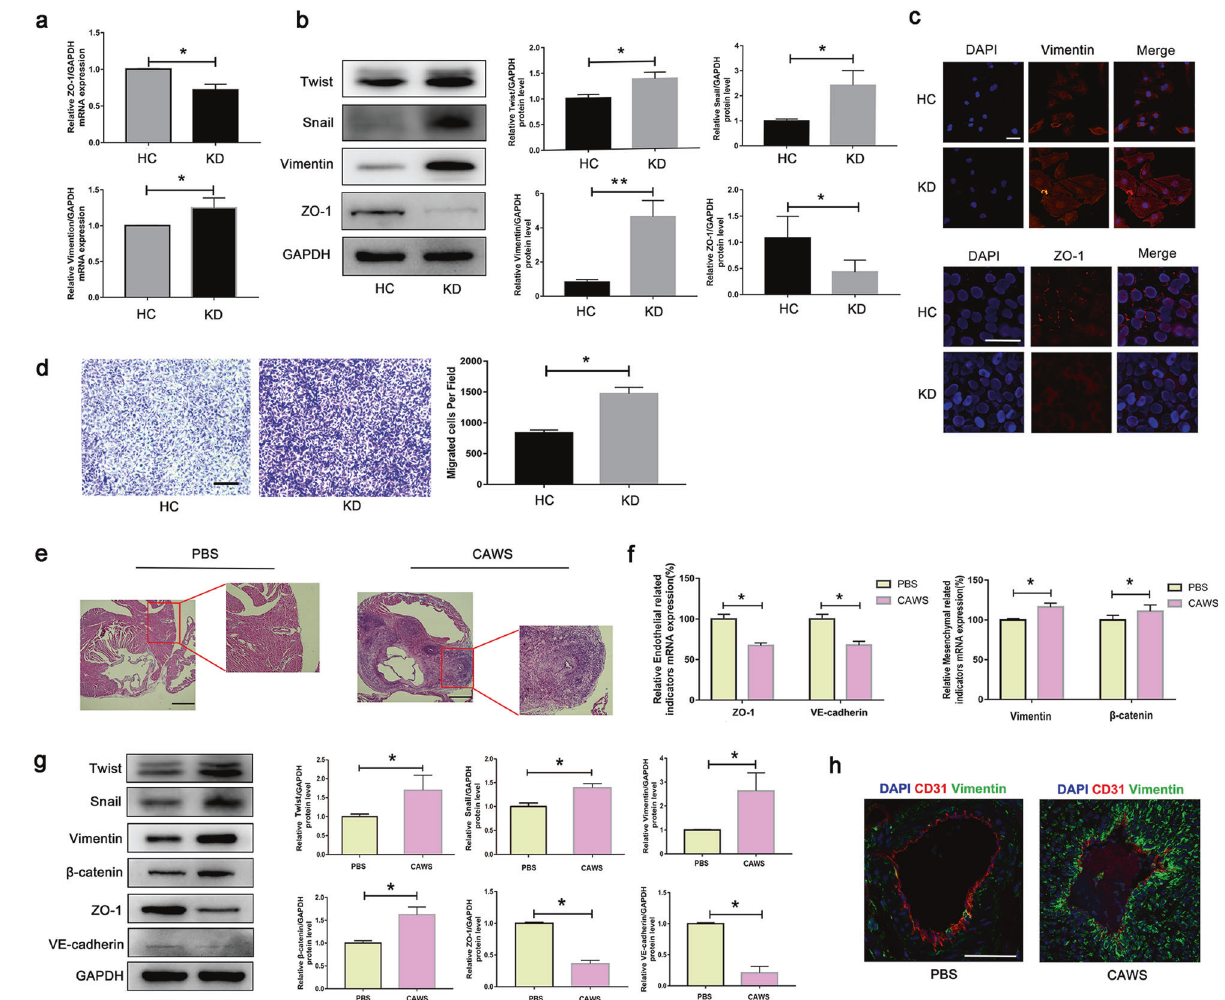
Fig. 1 EndMT existed in both in vitro and in vivo KD models. a – c HUVECs were treated with medium containing 15% sera from health control (HC) ( n = 6) or KD subjects (KD) ( n = 6). After 48 h, the treated endothelial cells were harvested. ZO-1 and Vimentin mRNA levels were measured by RT-qPCR analysis ( a ). The protein levels of Twist, Snail, Vimentin and ZO-1 were examined by western blotting ( b ). The expression of Vimentin and ZO-1 were analyzed by immuno fl uorescence staining ( c ). Magni fi cation: ×400 for Vimentin staining, and magni fi cation:×1000 for ZO-1 staining. Scale bar = 50 μ m for c . d Migration ability was measured by transwell test. Magni fi cation: ×40. Scale bar = 100 μ m. e After the mice were injected with PBS or CAWS, they were fed normally for 6 weeks, and the heart aorta root sections were obtained for HE staining. Magni fi cation: ×40. Scale bar = 100 μ m. f – g The heart tissues were harvested, and the total RNA and protein were respectively isolated for determining the expression of endothelial and mesenchymal markers. h Vimentin expression was analyzed in coronary endothelial cells using Vimentin/CD31 double staining. Magni fi cation:×400. Scale bar = 50 μ m. * P < 0.05 and ** P < 0.01 vs. the HC group or PBS